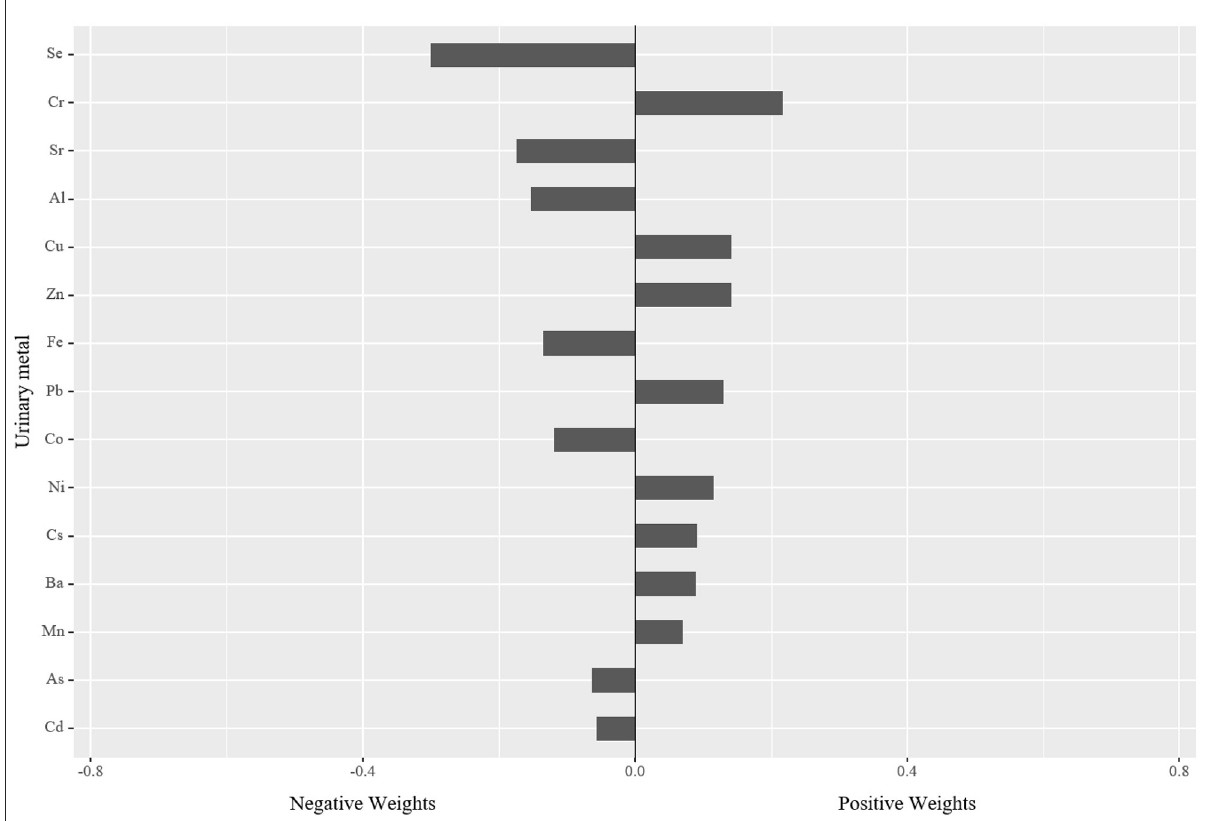
FIGURE1 The qgcomp model regression index weights for serum albumin associated with element mixtures with adjustment for age, sex, BMI, educational attainment, cigarette smoking habits, alcohol consumption habits, hypertension status, and diabetes status. BMI, body mass